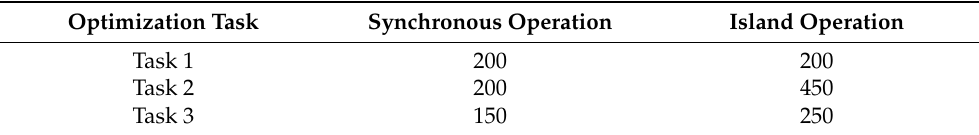
Table 3. Number of iterations of the optimization algorithm.